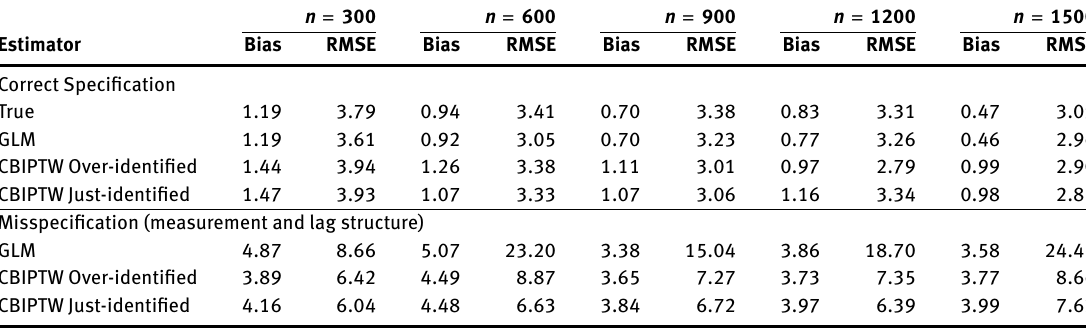
Table 1: Performance of Probability Weights Estimation Methods (Normal Homoscedastic Treatment-Assignment DGP). n = 300 n = 600 n = 900 n = 1200 n = 1500 Estimator Bias